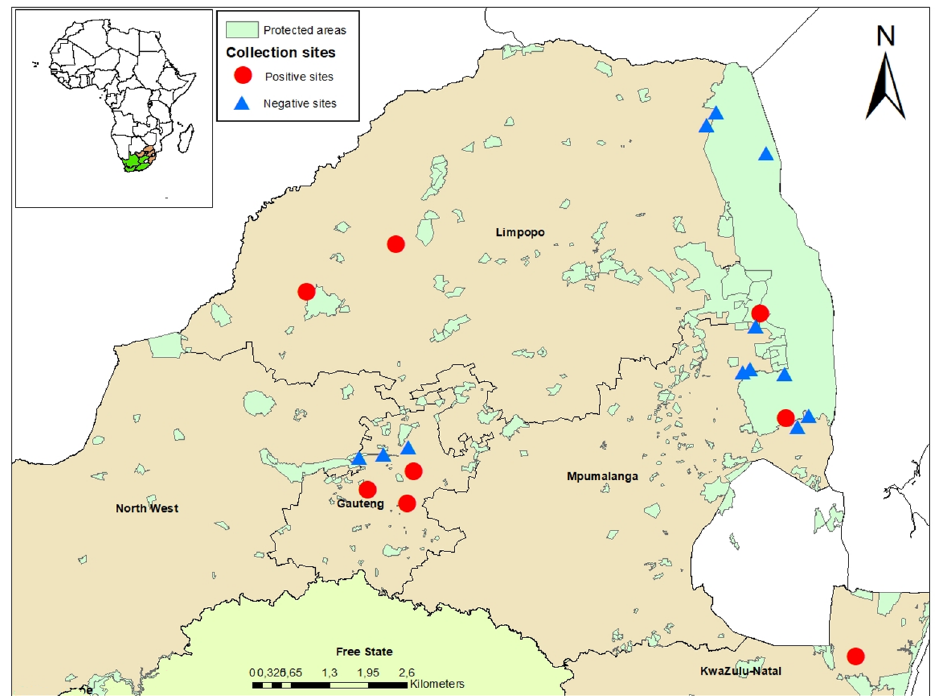
Figure 1. Mosquito collection sites indicating collection locations for alphavirus-positive (circles) and negative (triangles) mosquito pools. Sites were surveyed from January 2014 to May 2018 in South Africa.